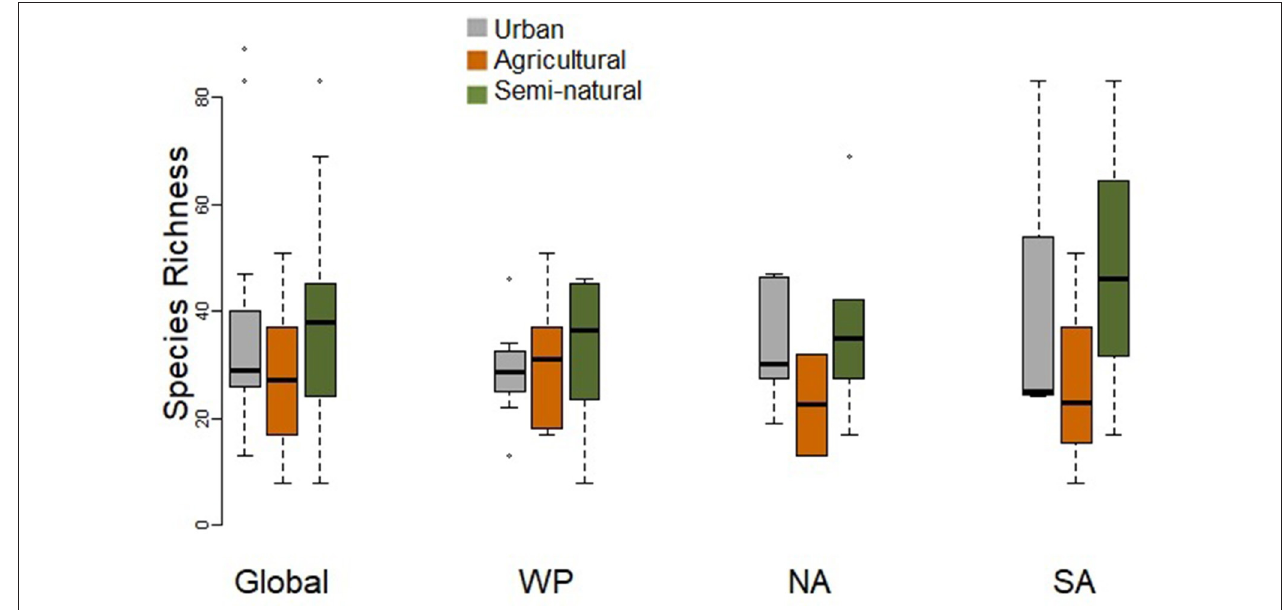
FIGURE 2 | Box-plot comparing species richness of paired urban and non-urban assemblages (in either natural or agricultural habitats) at the global scale and for the Western Palearctic (WP), North America (NA), and South America (SA). Paired t -tests did not find any significant differences ( Table 2 ).